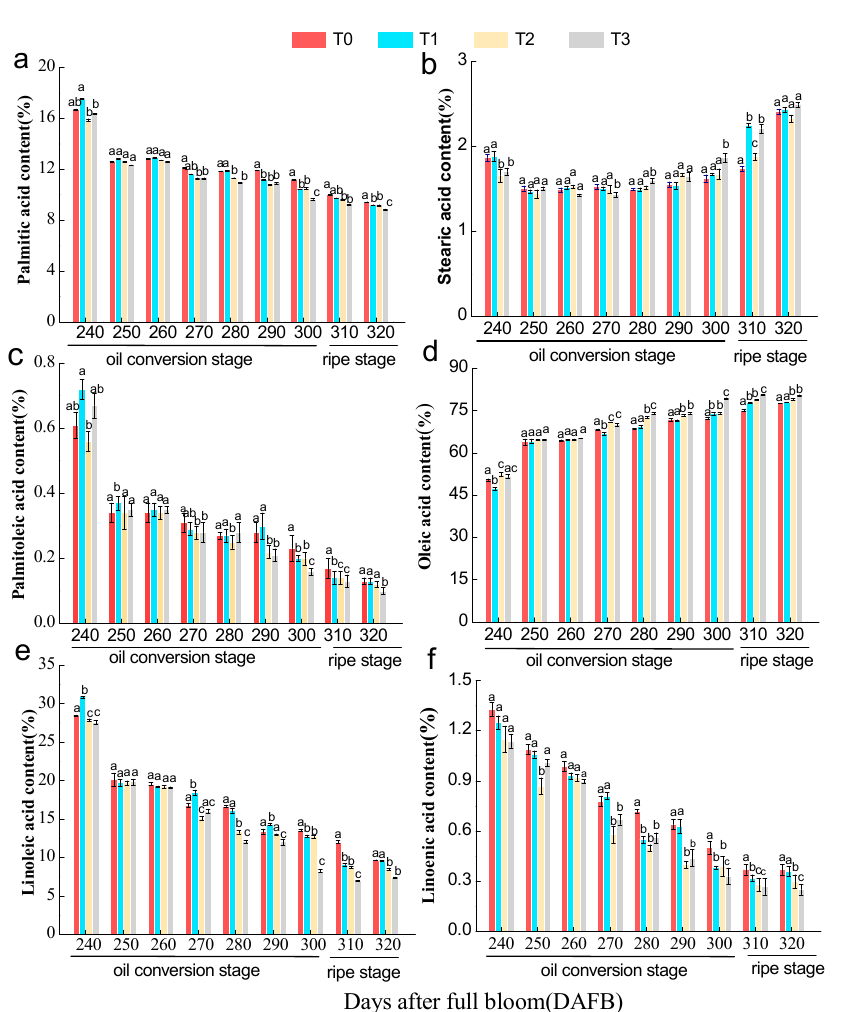
Figure 4. Changes in the palmitic acid (PA ( a )), stearic acid (SA ( b )), palmitoleic acid (POA ( c )), oleic acid (OA ( d )), linoleic acid (LA ( e )), and linolenic acid (LOA ( f )) contents of C. oleifera fruit seed kernel under different flower bud load treatments from 240 days after full bloom (DAFB) to 320 DAFB. Treatments: T0, removed 0% of the tree flowers; T1, removed 20% of the tree flowers; T2, removed 40% of the tree flowers; T3, removed 60% of the tree flowers. Different lowercase English letters (a, b and c) in the graph indicate significant differences between treatments ( p <